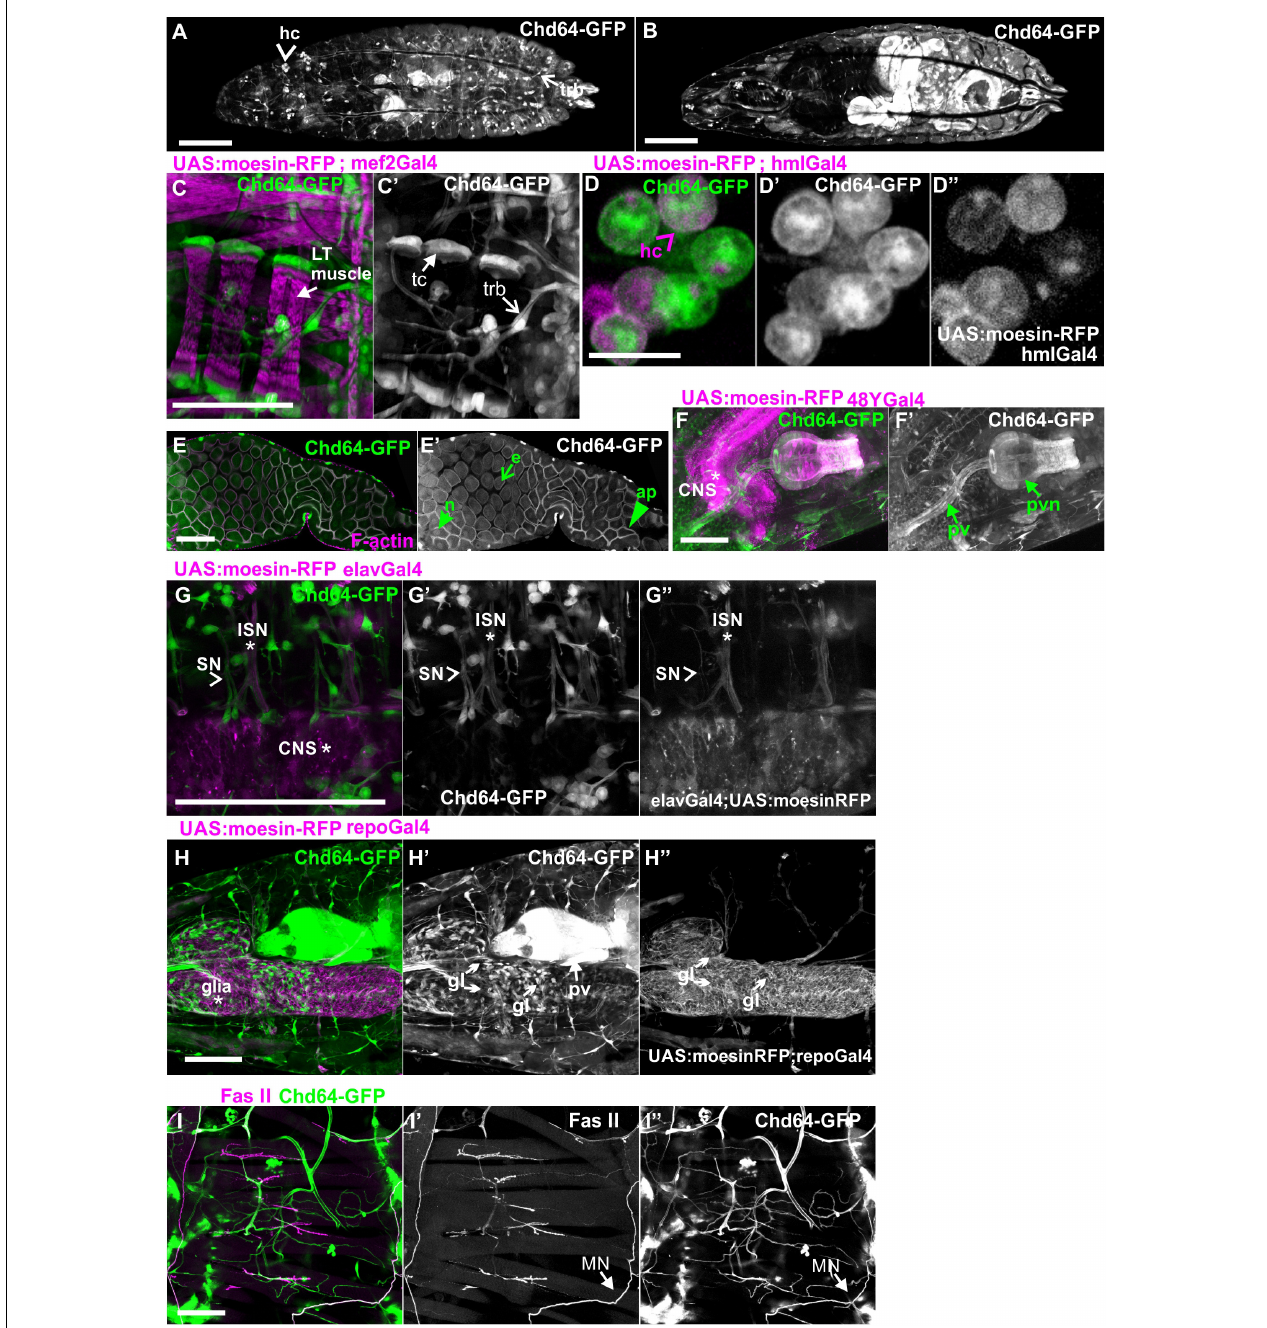
FIGURE 6 | Chd64-GFP protein expression in several cell types in larvae. (A,B) First-instar larvae expressing Chd64-GFP. (A) Confocal projection of optical sections derived from the external dorsolateral side of the larvae to show endogenous expression in hemocytes and tracheal branches. (B) Confocal projection of optical sections derived from the interior part of the same larvae to show the intense expression of Chd64-GFP in the gut. (C–I) Chd64-GFP endogenous expression in several cell types including (C,C (cid:48) ) tracheal branches and tendon cells at the tips of the LT muscles labeled with the expression of UAS:moesin-RFP under the mef2Gal4 ; (D–D (cid:48)(cid:48) ) hemocytes labeled with UAS:Moesin-RFP driven by hmlGal4 ; (E,E (cid:48) ) enterocytes in the midgut area labeled also with F-actin, which is enriched apically together with Chd64-GFP; (F,F (cid:48) ) endodermally originating cells along the gastrointestinal tract in the proventriculus area, labeled with UAS:Moesin-RFP driven by 48YGal4 ; (G–G (cid:48)(cid:48) ) motor neurons labeled with UAS:Moesin-RFP driven by elavGal4 ; (H–H (cid:48)(cid:48) ) glia cells residing in the CNS labeled with UAS:Moesin-RFP driven by repoGal4 ; and (I–I (cid:48)(cid:48) ) peripheral neurons innervating somatic muscles labeled with FasII. Each image is representative of at least four different imaged larvae of the same genotype and markers used. hc, hemocytes; LT, longitudinal; trb, tracheal branch; tc, tendon cells; pv, proventriculus; pvn, proventricular nerve; CNS, central nervous system; ISN, intersegmental nerve; SN, segmental nerve, gl, glia. Scale bars: 100 µ m in all panels, except (D) : 5 µ m.